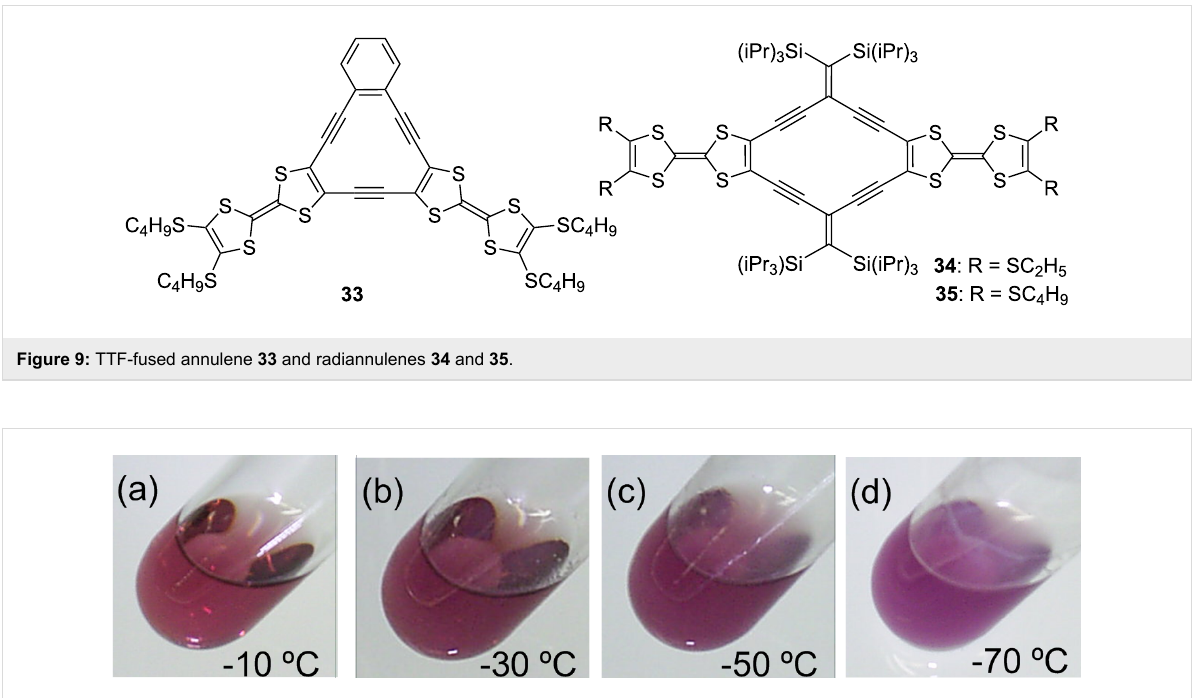
Figure 10: Colors of 30 solutions a–d in toluene (0.025 mM) at various temperatures. (a) λ max : 511 nm, (b) λ max : 512 nm, (c) λ max : 517 nm, (d) λ max : 520 nm. Reprinted with permission from [68]. Copyright 2012 Chemical Society of Japan.